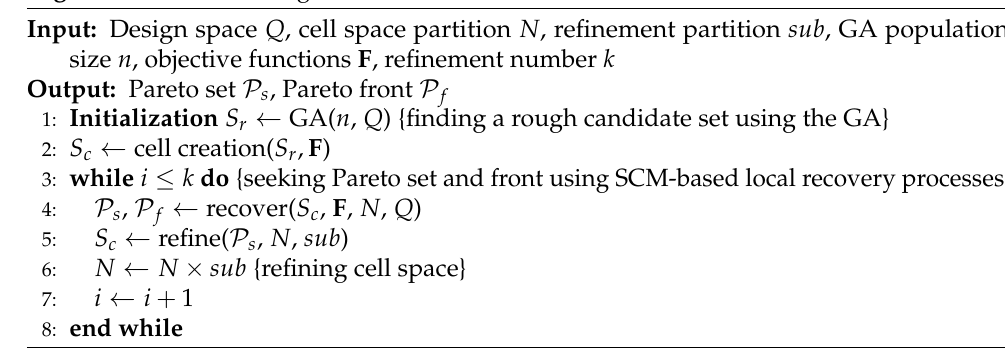
Algorithm 1 GA-SCM algorithm.